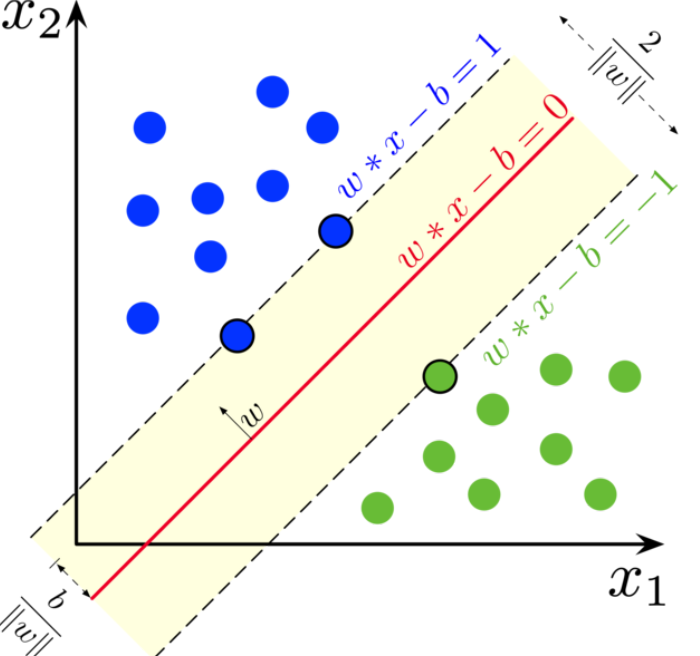
Figure 2. Support vectors on yellow area, are used to create boundaries also known as hyperplanes. The SVM in the figure is using a linear kernel denoted by the straight line equation. Image distributed under a CC BY-SA 4.0